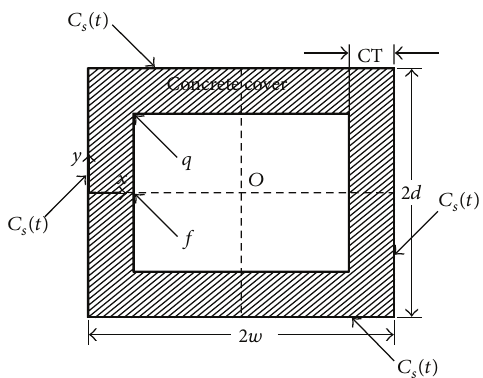
Figure 1: Schematic diagram of a cross section of the column under